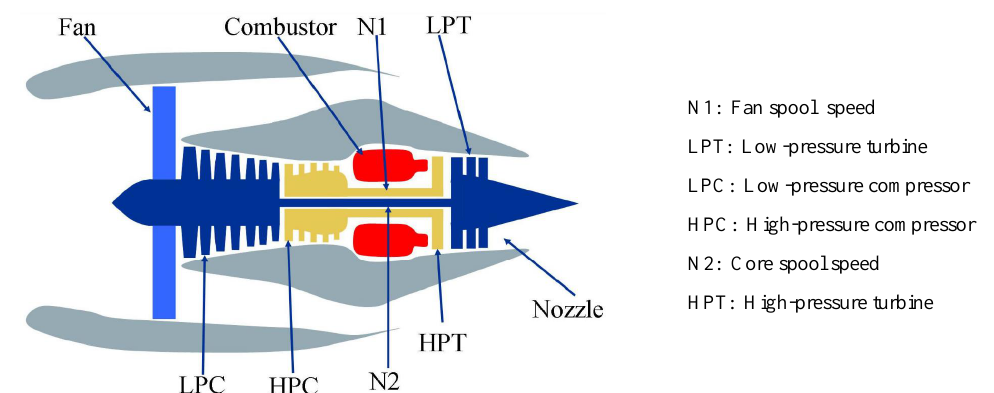
Figure 6. Diagram of the engines in C-MAPSS [68] dataset. Reprinted with permission from Ref. [68]. Copyright 2008